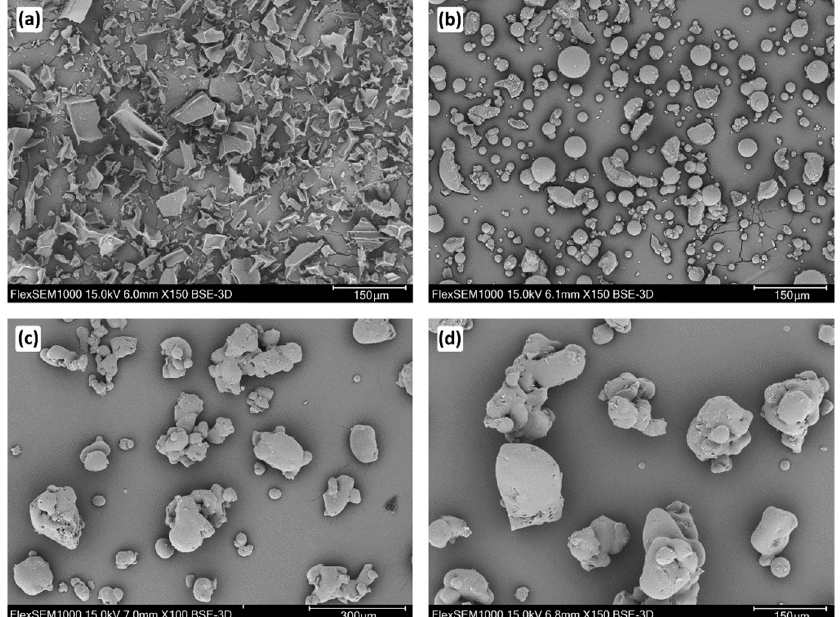
Figure 4. Scanning electron microscopy images of the vancomycin powder (150× magnification) ( a ), the gentamicin powder (150× magnification) ( b ), the PLGA solid dispersion (100× magnification) ( c ), and the PLGA solid dispersion (150× magnification) ( d ).